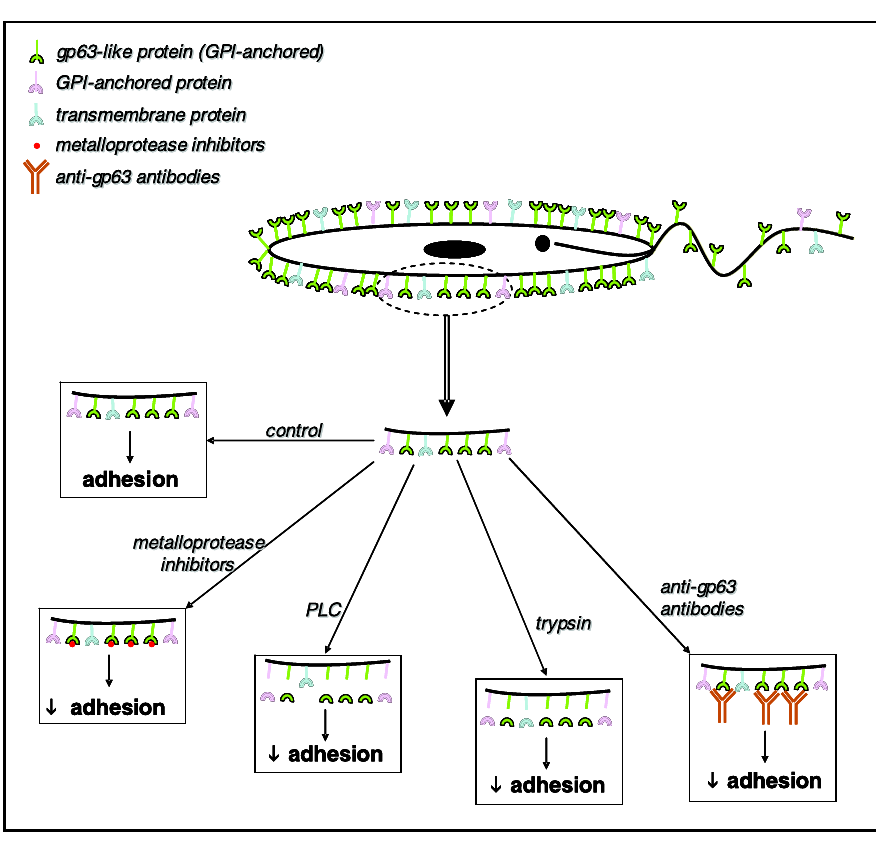
Fig. 8 – Different approaches employed for the demonstration of a proposed role performed by the gp63-like cell surface molecules on the interaction of lower trypanosomatids with the invertebrate host. The schematic representation shows a trypanosomatid cell expressing at the surface gp63-like molecules and other glycosylphosphatidylinositol (GPI)-anchored or transmembrane proteins. The adhesion rate to the insect epithelium in vitro is evaluated in untreated ( control ) or parasites previously treated with metalloprotease inhibitors , phospholipase C ( PLC ), trypsin or anti-gp63 antibodies . These treatments led to reduced levels of adhesion ( ↓ adhesion), due to removal or inactivation of gp63-like proteins from the cell